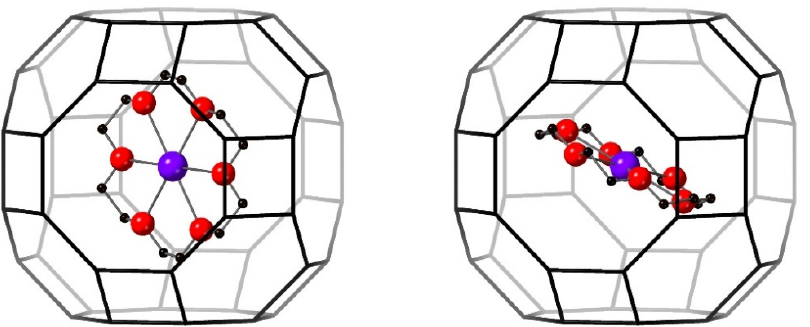
Figure 8. Location of the C and O sites of the 18C6 oxyethylene chain in the α -cage of the filled zeolite ZK-5. Included is the position of the K(4) cation site, as shown by a purple sphere. An example of two 18C6 orientations in the cage are shown. The framework is shown as a stick model, the carbon sites as black spheres and the oxygen sites as red spheres.